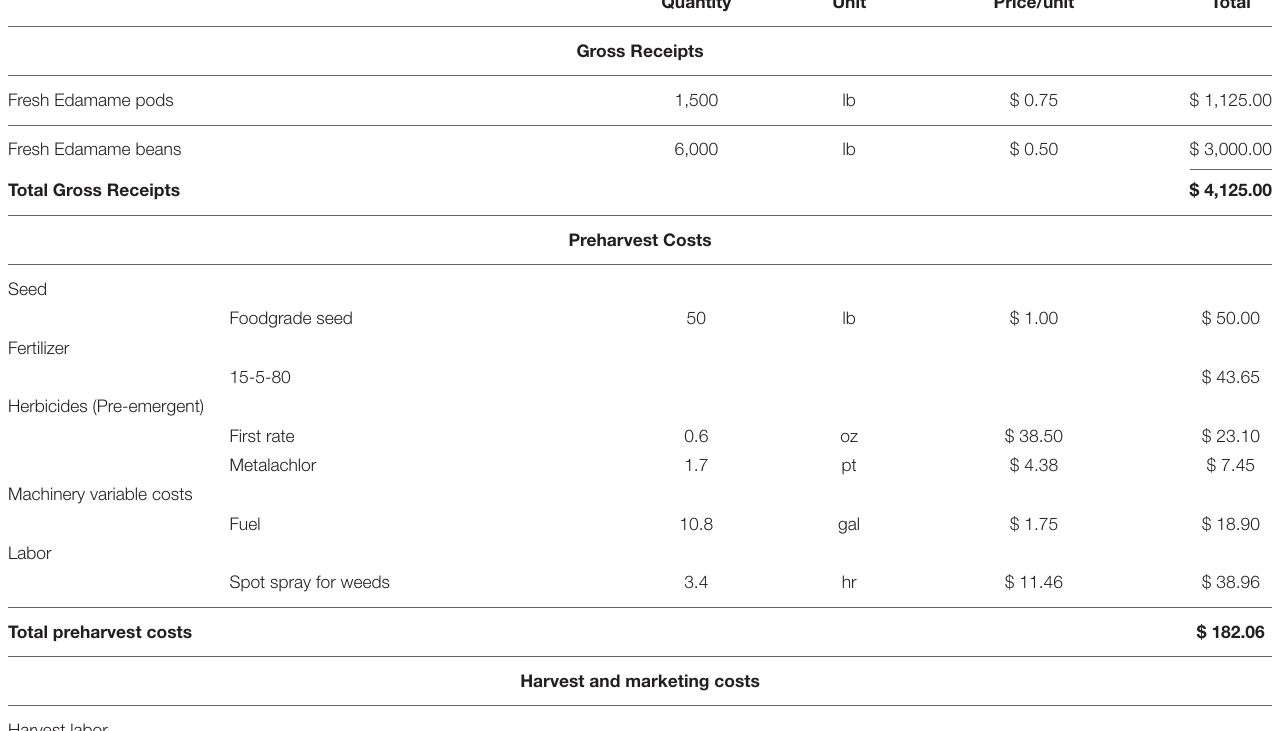
Quantity Unit Price/unit Total Gross Receipts